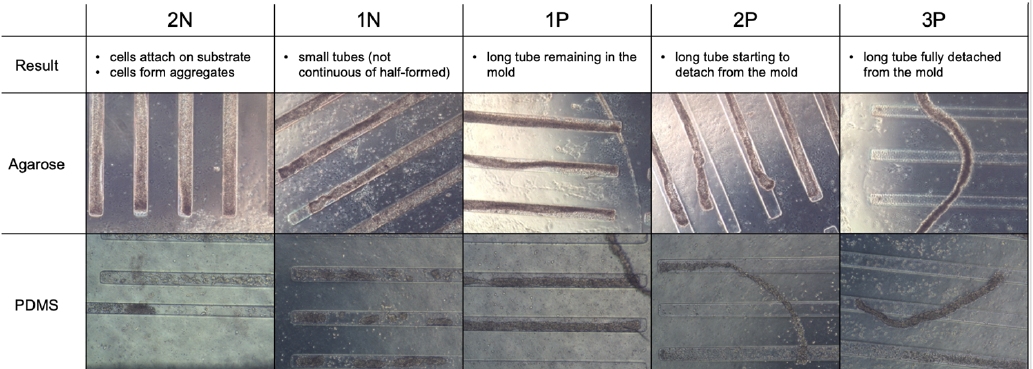
Figure 3. The efficiency of tube formation was graded after 24 h of culture along the characteristics shown in the panels. Tube formation was scored by grades (from low to high) as 2N ( −− ), 1N ( − ), 1P (+), 2P (++) and 3P (+++).